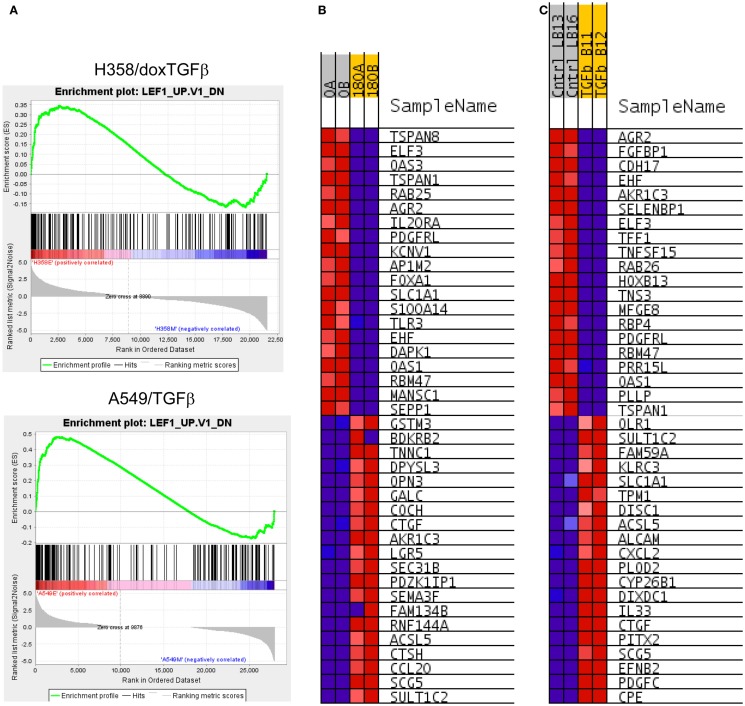
(A) Correlation of H358 and A549 EMT regulated genes with the LEF1 signature from LEF1 over-expressing epithelial DLD1 cells (from GSE3229). Normalized enrichment score (NES) was 2.63, nominal p-value, FDR q-value, and FWER p-value were <0.001. (B) The top 20 positively and negatively correlated genes were identified and heat mapped for H358 (B) control [0; A, B] and TGFβ [180; A, B] duplicate samples) and (C) for A549 (control [Cntrl; LB13, LB16] and TGFβ [TGFb; B11, B12] duplicate samples).